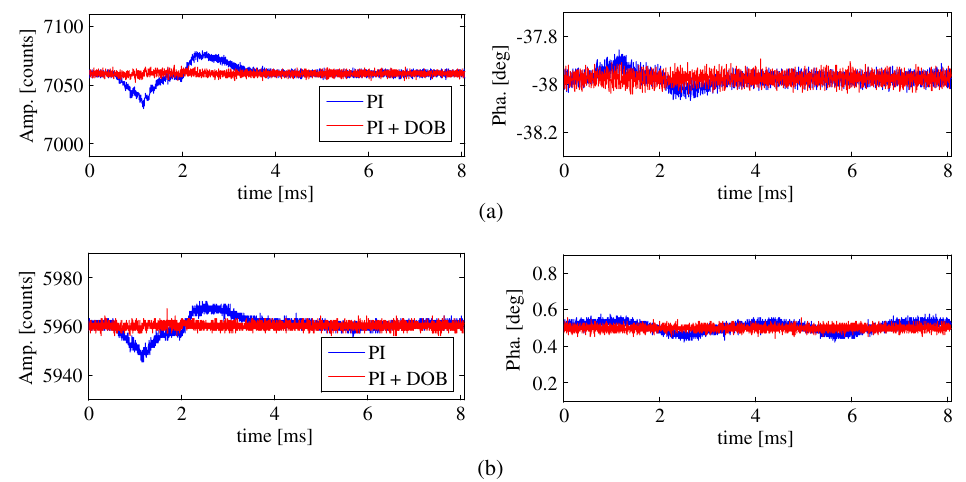
FIG. 18. The measured rf field for the amplitude (left) and the phase (right) on the cavities of the injectors in the presence of 800 μ A beam loading. The blue and red waveforms in each subplot represent the PI control and PI þ DOB control ( f The operated beam currents are (a) injector 1 and (b) injectors 2 and